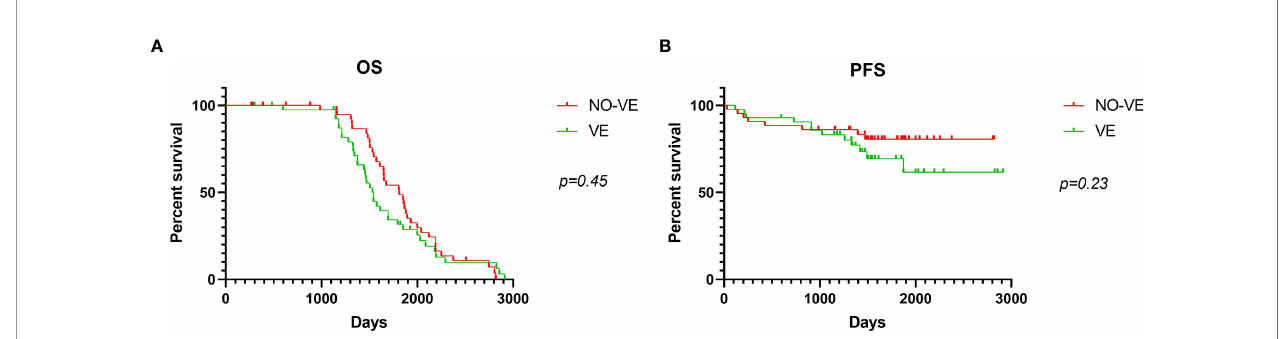
FIGURE 3 | Kaplan-Meier curve analysis according to ventricular entry. OS (A) and PFS (B) analysis using Kaplan-Meier curves in patients with or without ventricular entry. VE means